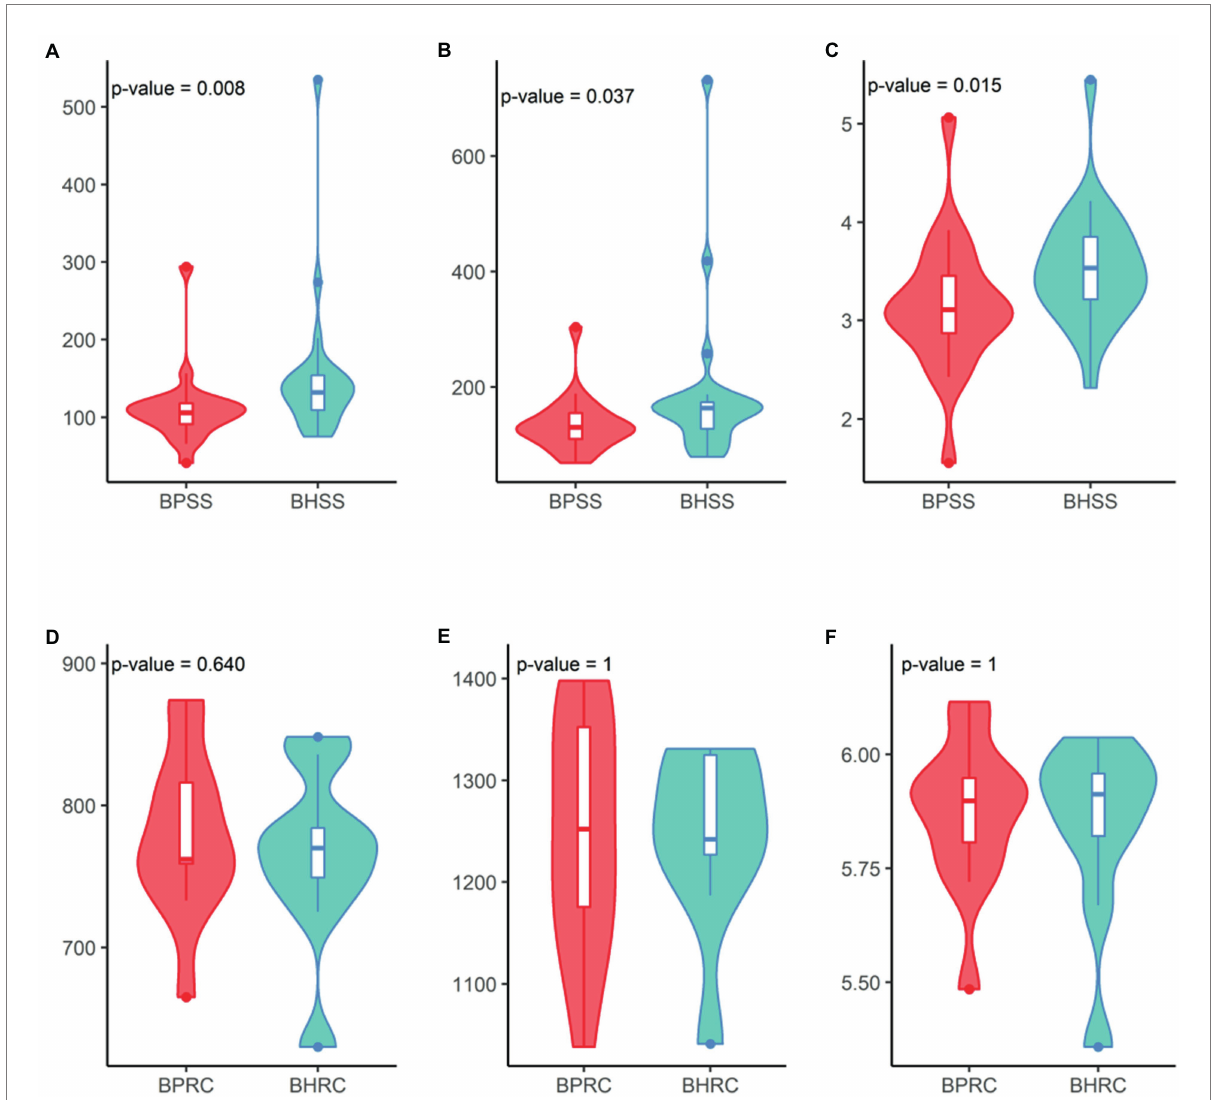
FIGURE 5 Diversity analysis in dental and ruminal bovine microbial profiles in health and periodontal disease. Dental profile (BHSS—healthy animals; BPSS— bovines with periodontitis): (A) Observed species richness or number of OTUs per sample; (B) Estimated species richness or Chao-1; (C) . Shannon diversity index. Ruminal profile (BHRC—healthy animals; BPRC—bovines with periodontitis): (D) Observed species richness or number of OTUs per sample; (E) Estimated species richness or Chao-1; (F) Shannon diversity